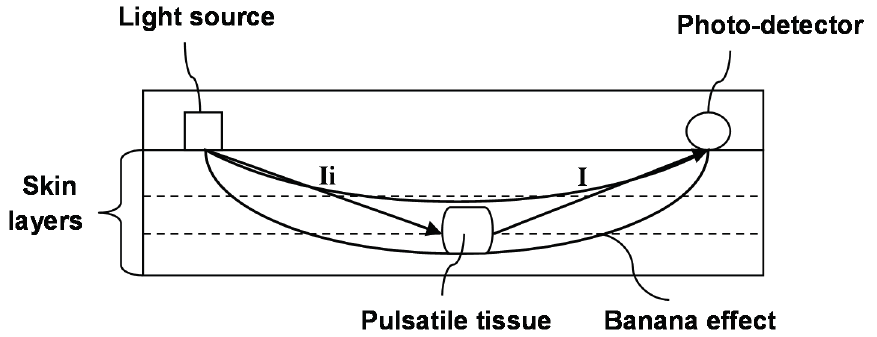
Figure 7. Banana shape effect on reflection mode